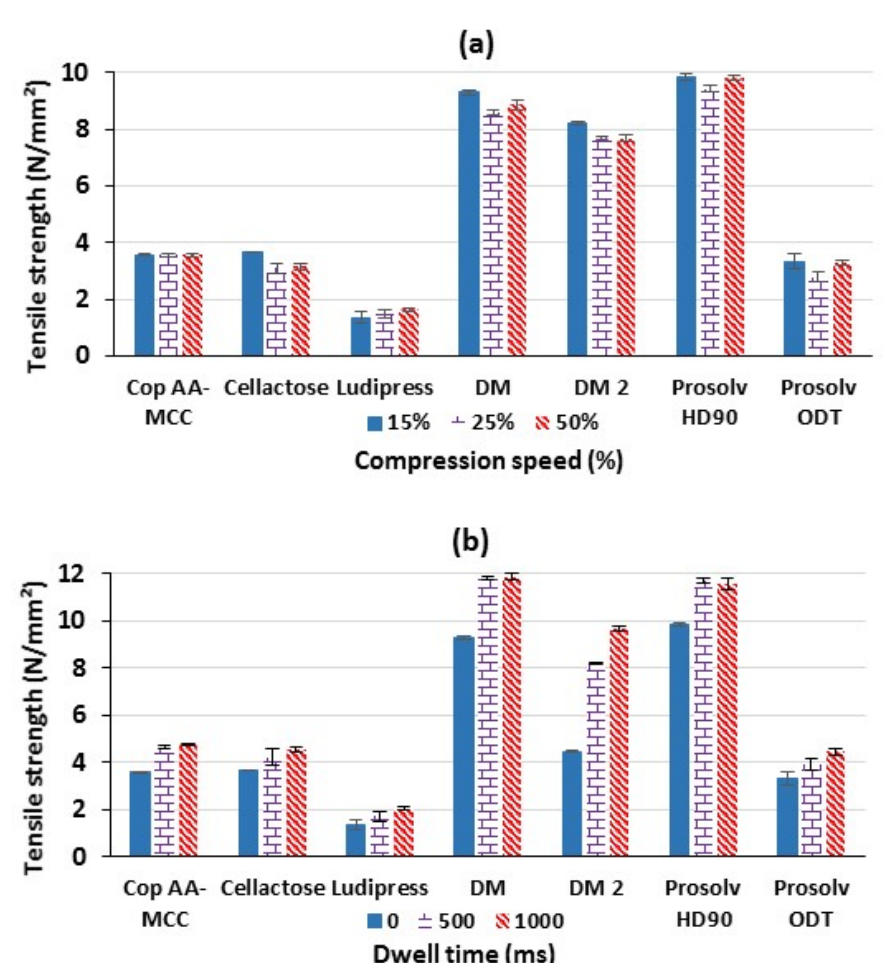
Figure 6. Effect of ( a ) compression speed and ( b ) dwell time on tablet’s tensile strength, at 200 MPa.